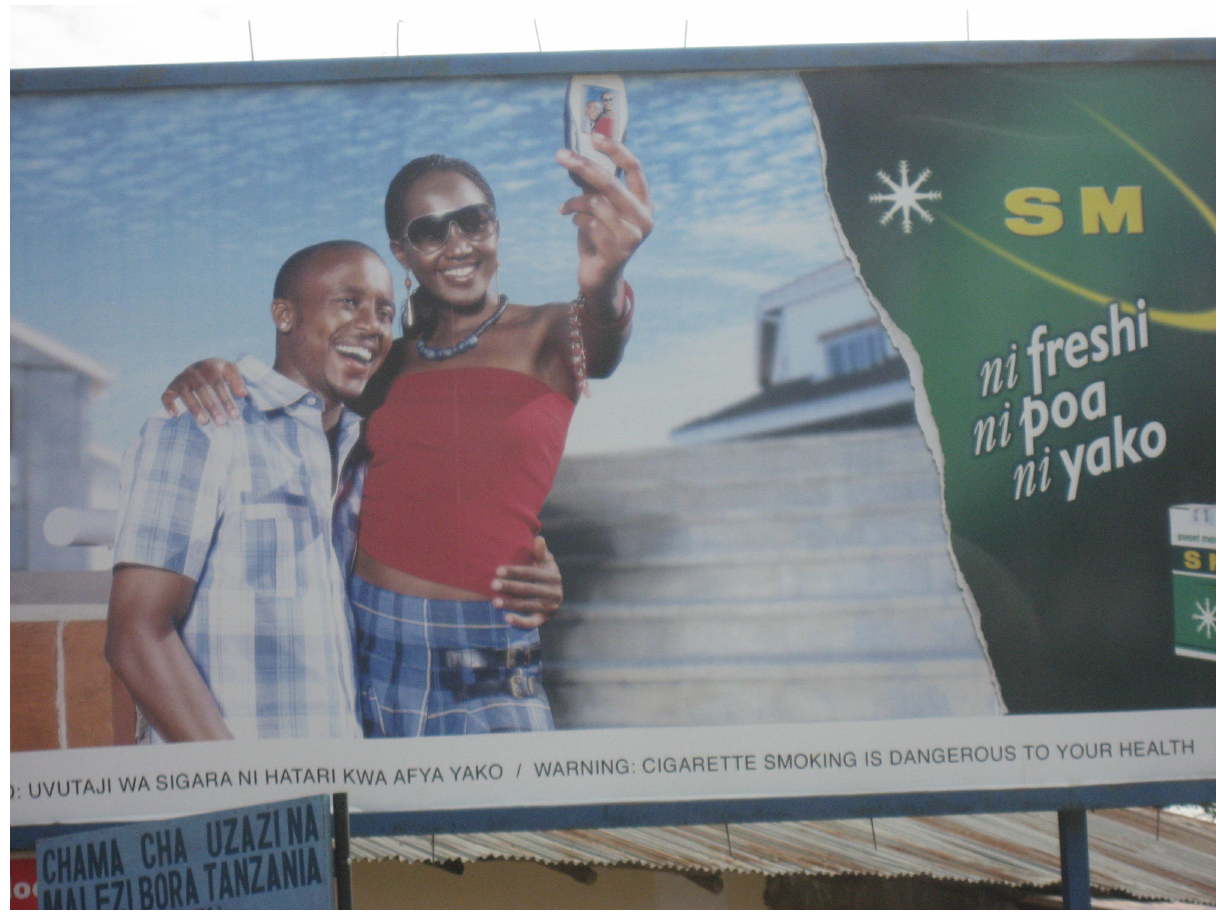
Figure 1. Cigarette billboard advertisement, Arusha, Tanzania, January